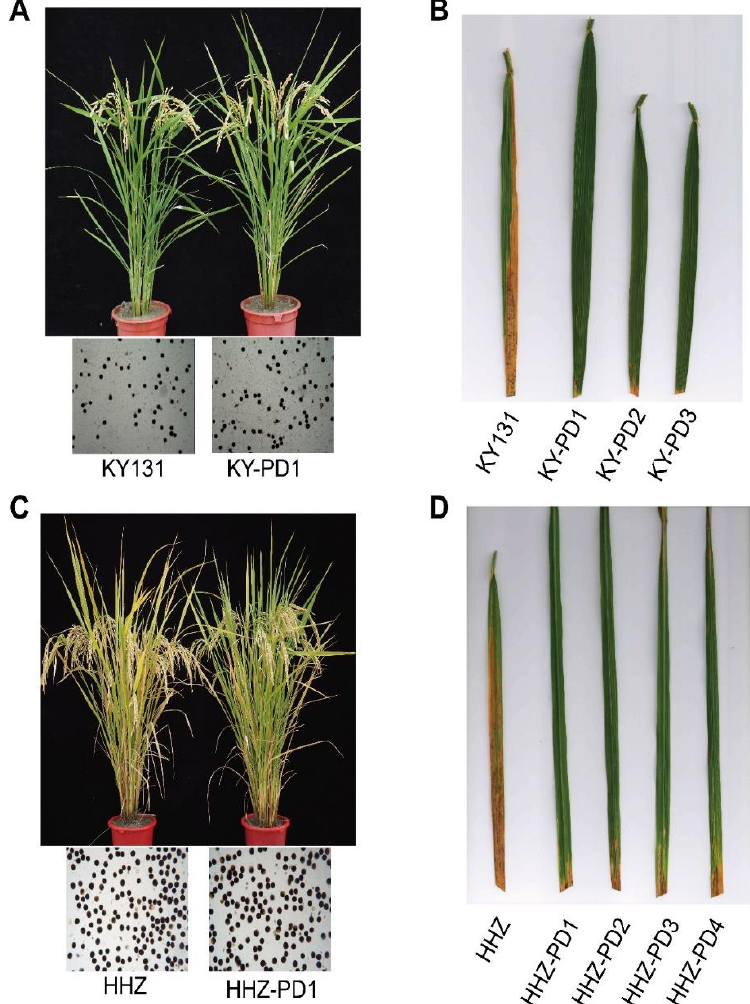
Figure 3. Agronomic traits, bacterial leaf blight resistance, and pollen fertility of wild-type and transgenic rice plants (KY-PD1 and HHZ-PD1). ( A ) Agronomic traits and phenotype detection of the wild-type KY131 and transgenic rice KY-PD1. There was no significant difference between transgenic rice KY-PD1 and the wild type in terms of agronomic traits. Transgenic plants KY-PD1 showed similar pollen fertility to the wild-type KY131 after I 2 -KI staining of pollen. ( B ) Lesion length of the wild-type KY131 and transgenic plant KY-PD1-3 after 14 days of inoculation. Resistance of transgenic plants KY-PD1-3 was much higher than that of the wild-type KY131. ( C ) Agronomic traits and genotype detection of the wild-type HHZ and transgenic rice HHZ-PD1. There was no significant difference between transgenic rice HHZ-PD1 and the wild type in terms of agronomic traits. Transgenic plants HHZ-PD1 showed similar pollen fertility to the wild-type HHZ after I 2 -KI staining of pollen. ( D ) Lesion length of the wild-type HHZ and transgenic plant KY-PD1-3 after 14 days of inoculation. Resistance of transgenic plants HHZ-PD1-4 was much higher than that of the wild-type